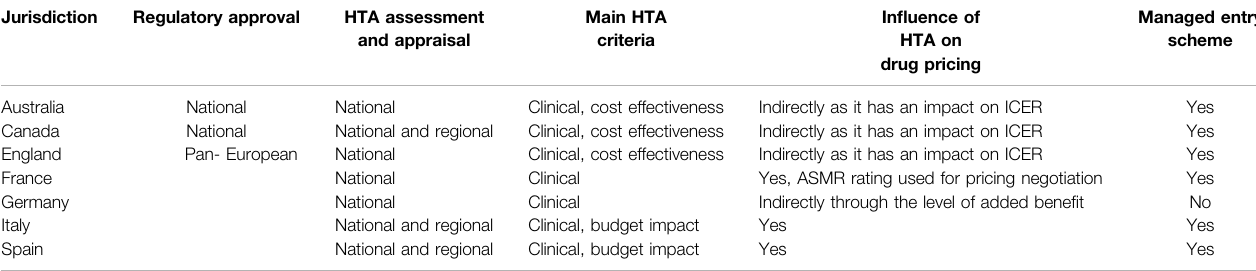
TABLE 1 | Summary of key features of HTA